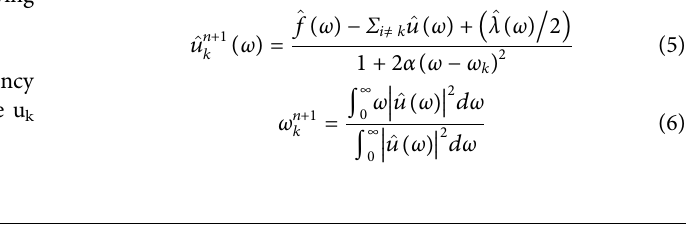
TABLE 2 | Parameters of VMD decomposition and LSTM